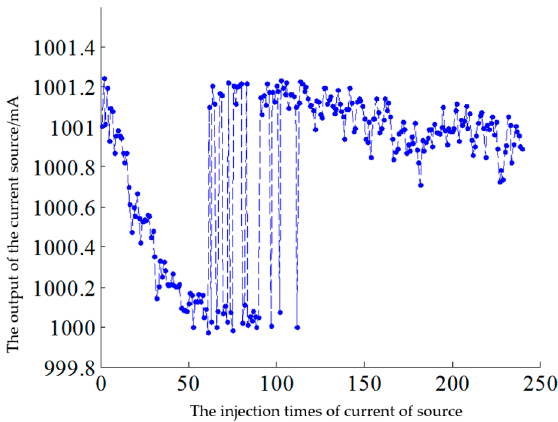
Figure 6. The output current test curve with 1 Ω .